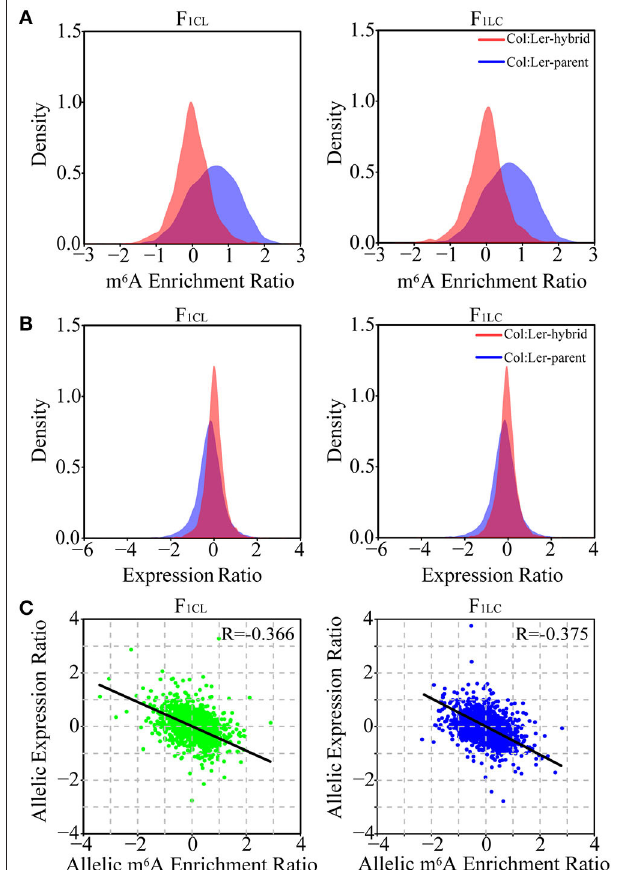
FIGURE 4 | Relationship between allelic gene expression and allelic m 6 A methylation in F 1 hybrids. Density distribution of the (A) m 6 A enrichment ratio and (B) gene expression ratio between allelic sites of Col-0 and Ler (marked as Col: Ler-parent) and the ratio between allelic sites inherited from Col-0 and Ler in the hybrids (Col: Ler-hybrid). (C) Scatter plot showing the correlation between allele-specific expression and allele-specific m 6 A methylation in the hybrids. Only the reads of m 6 A-seq or RNA-seq mapped to the SNPs between Col-0 and Ler with high confidence are used in the